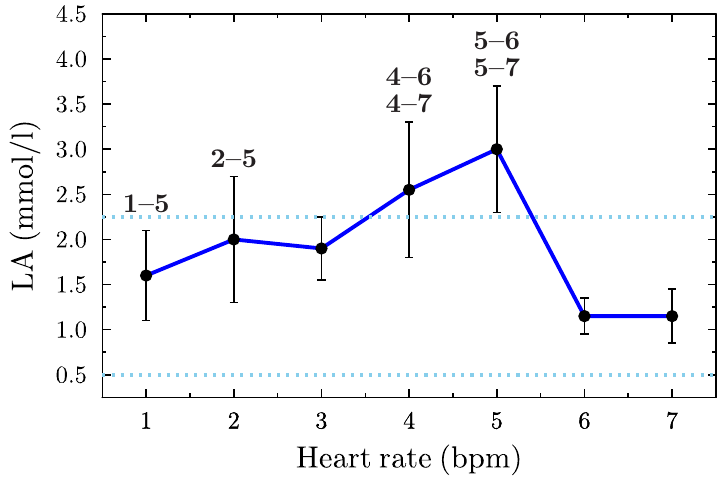
Figure 4. Changes in the concentration of lactic acid in blood of the runners examined.